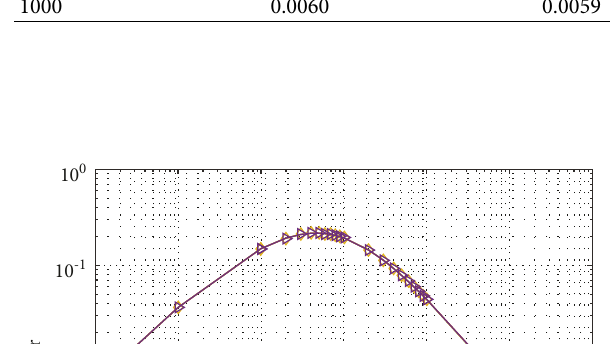
Figure 3: Instantaneous error versus β Table 3: Data of instantaneous error versus β